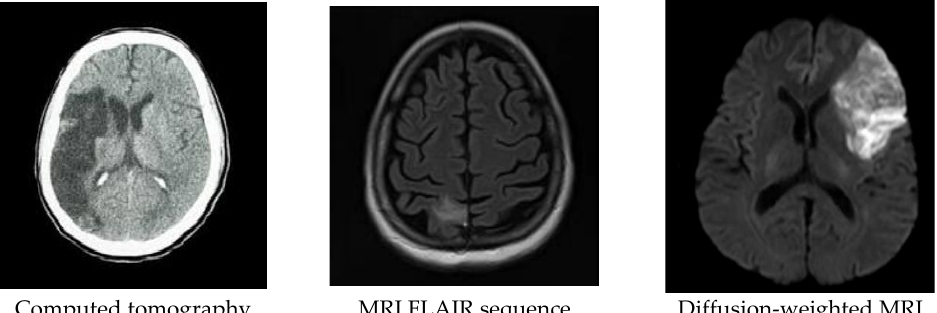
Figure 1. Neuroimaging in acute ischemic stroke of different patients. On computed tomography, infarct is seen as a hypointense region ( left ). With MRI, signal contrasts between different tissues can be amplified using different pulse sequences. With fluid attenuated inversion recovery (FLAIR), the infarct is depicted as a bright signal against surrounding brain tissue as well as the dark signal- suppressed cerebrospinal fluid ( center ). With DWI, the infarct tissue exhibits less signal decay as water diffusion becomes restricted, which shows up as a hyperintense area ( right ).